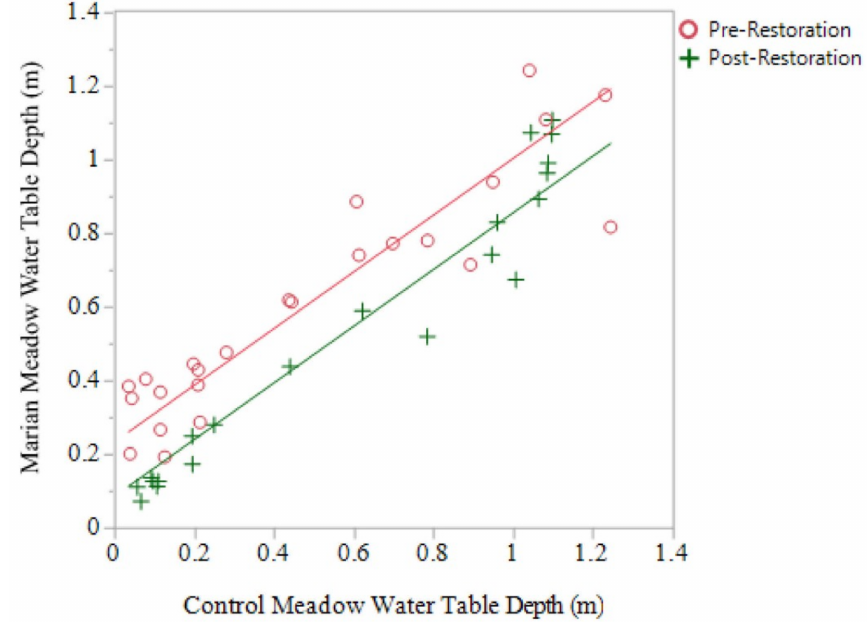
Figure 7. Regression analysis for the Control Meadow and Marian Meadow for pre- and post-restoration water table depth (depth to groundwater from the surface). Regression analysis based on average weekly measured water table depths with a lag of three weeks between data points to avoid serial autocorrelation.